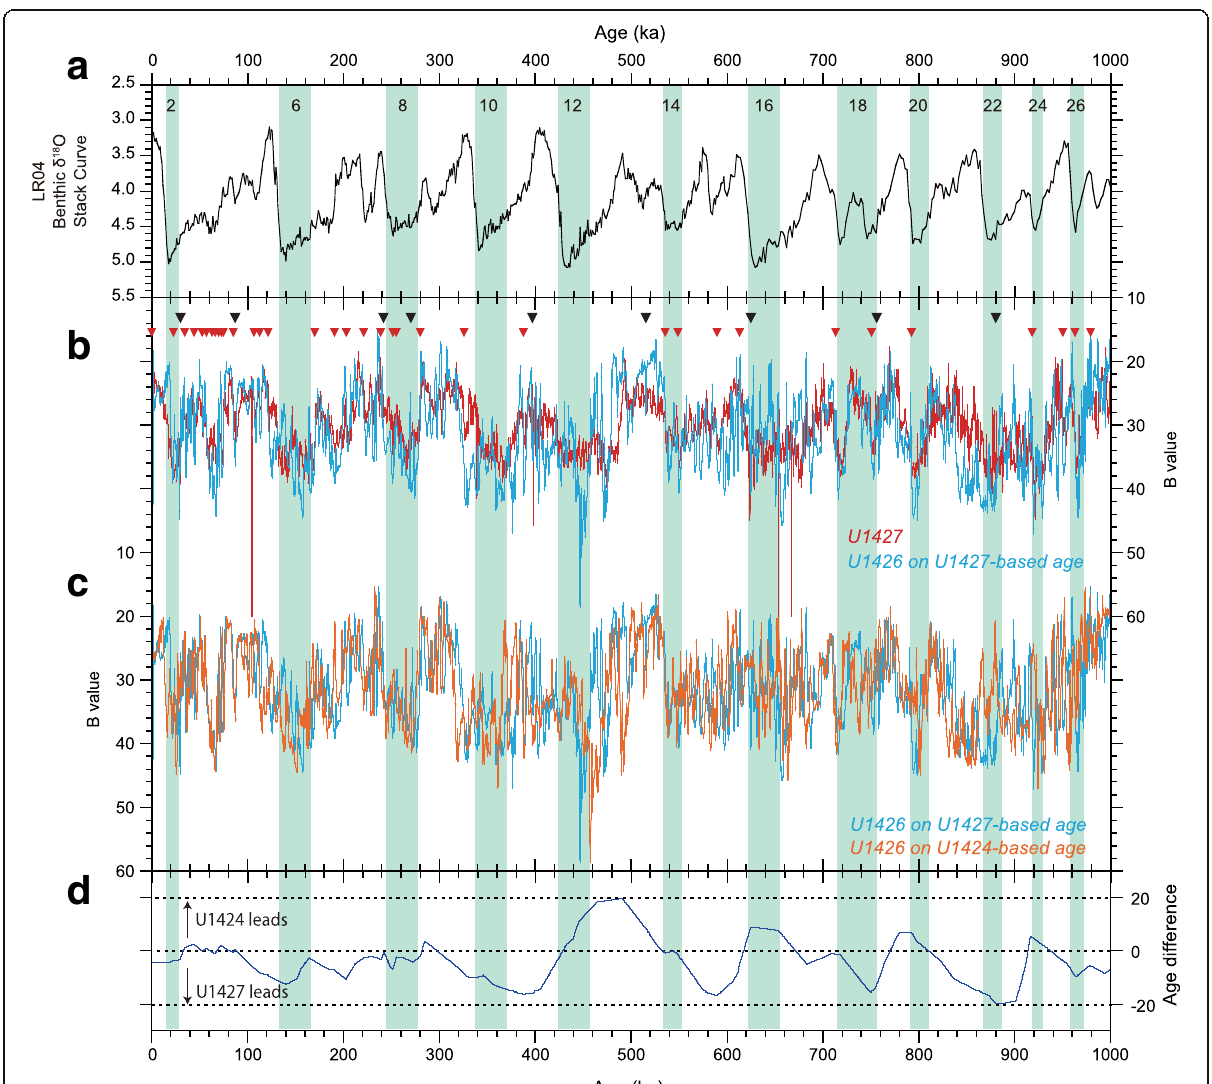
Fig. 10 a LR04 oxygen isotope stack. b Color variation at Sites U1426 and U1427 over the past 1.0 Myr. Note that the axis of B values is inverted. Control points by correlative tephra layers are shown by black triangles. Additional control points by color correlation are shown by red triangles. c Color variations at Site U1426 plotted on a U1427-based age model (blue) and a U1424-based age model (orange). d Age difference between U1427-based and U1424-based age estimates for the past 1.0